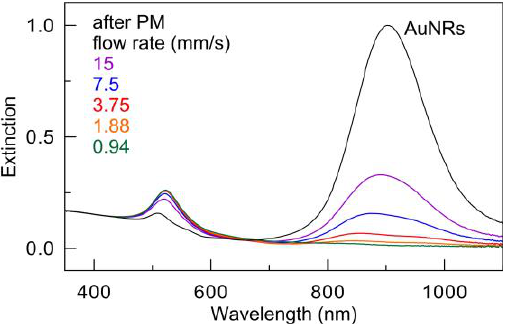
Figure 5. Extinction spectra of a colloid of AuNRs before (black) and after PM using a 900 nm pulsed laser with a fluence of 97 mJ/cm 2 and when moving through a capillary at a flow rate of 15, 7.5, 3.75, 1.88, and 0.94 mm/s, which corresponds to irradiation of 0.73, 1.47, 2.9, 5.9, and 11.7 laser pulses, respectively.